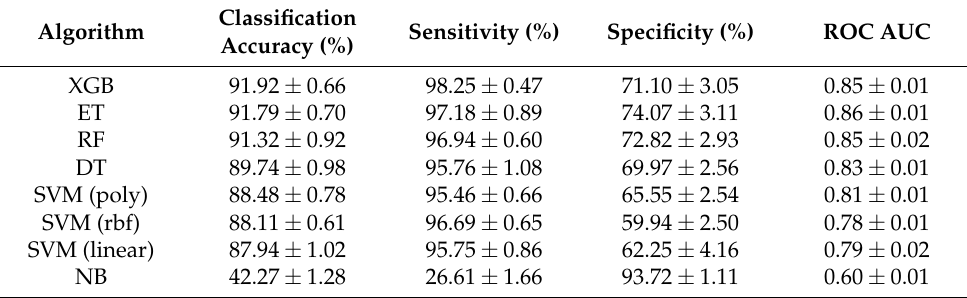
Table 10. Comparison of the best results for each algorithm (static analysis).